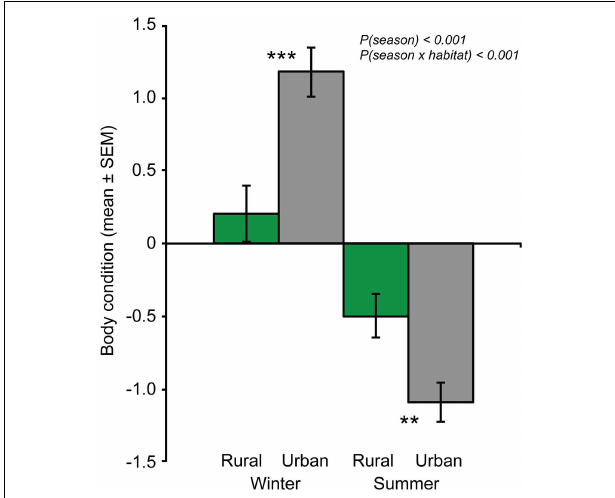
FIGURE 1 | Body condition (i.e., the residuals from a regression between body mass and tarsus length) of great tits in urban and rural habitats during winter and summer ( N total = 126 ). Significant effects from the model are indicated by the p -values. However, due to the significant season × habitat interaction, body condition of birds from the two habitats was also analyzed separately for each season, and significant differences between habitats within a season are indicated by asterisks ( ** p < 0.01; *** p < 0 . 001 ).